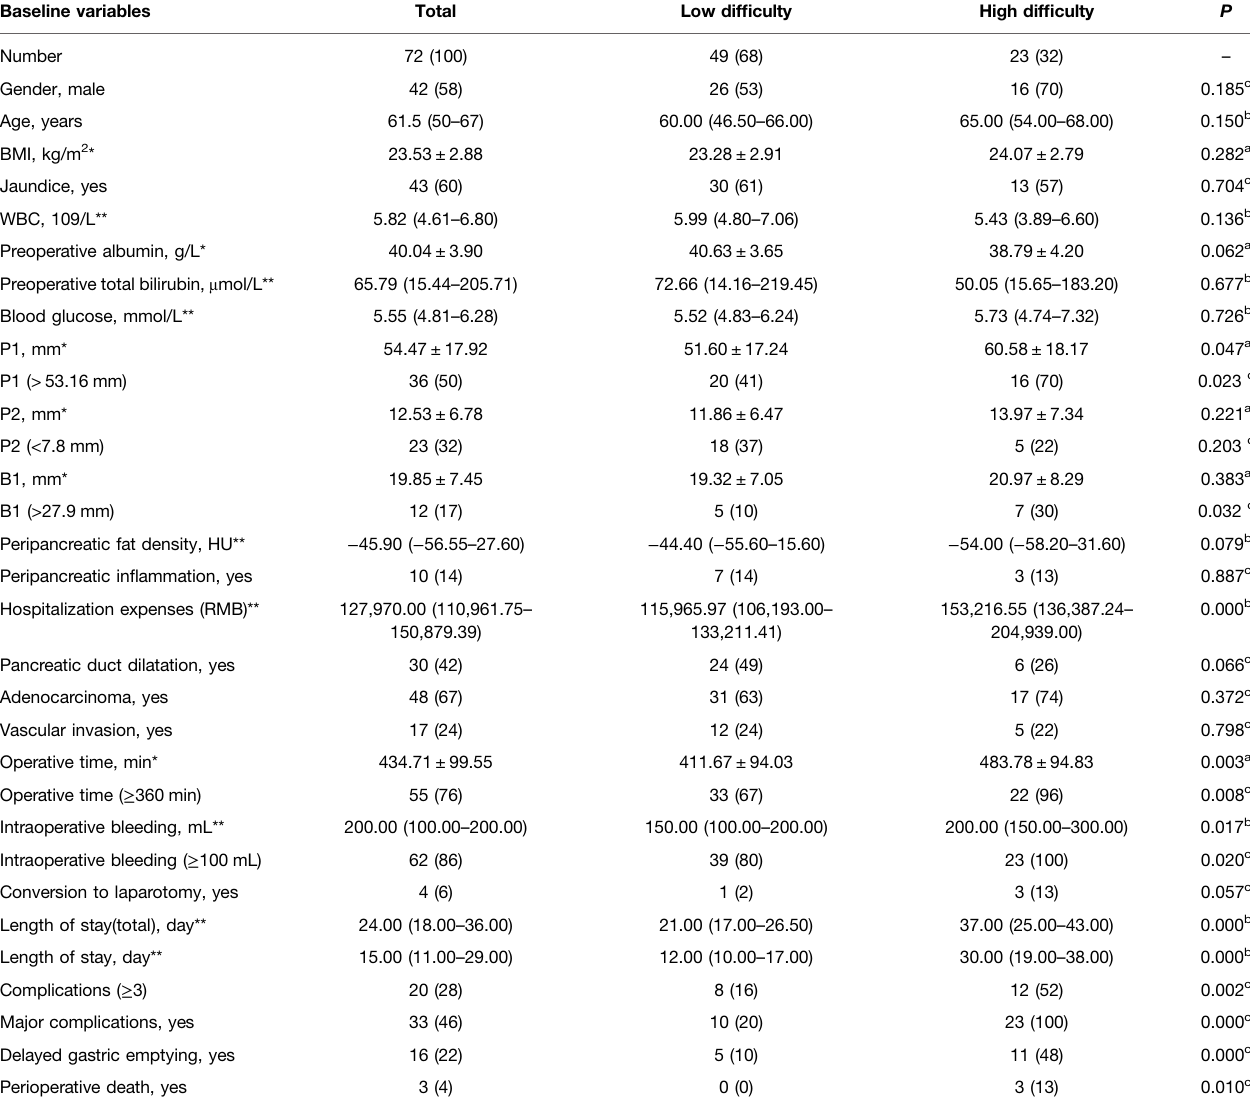
TABLE 1A | Baseline perioperative